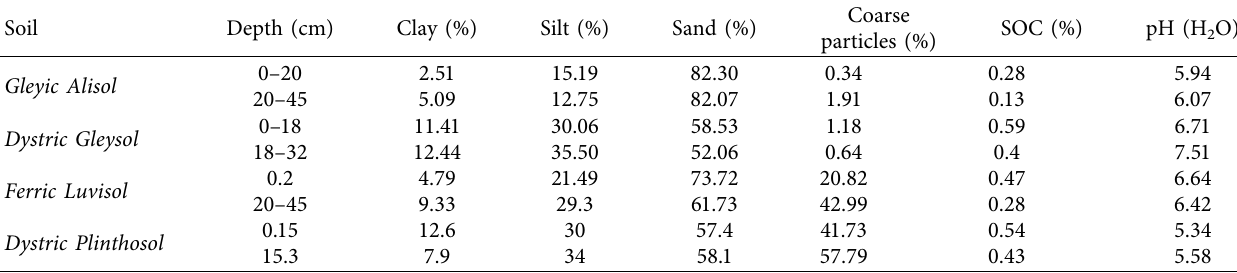
Table 2: Basic properties of the soil investigated. SOC refers to soil organic carbon.